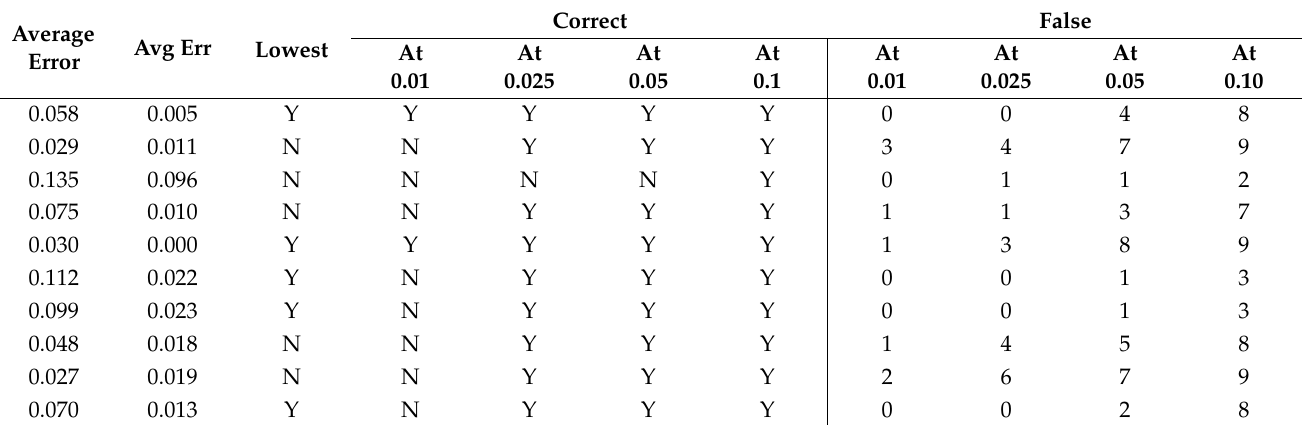
Table 11. Set 3, trials 41–50 summary data (single 0.5 PR value).